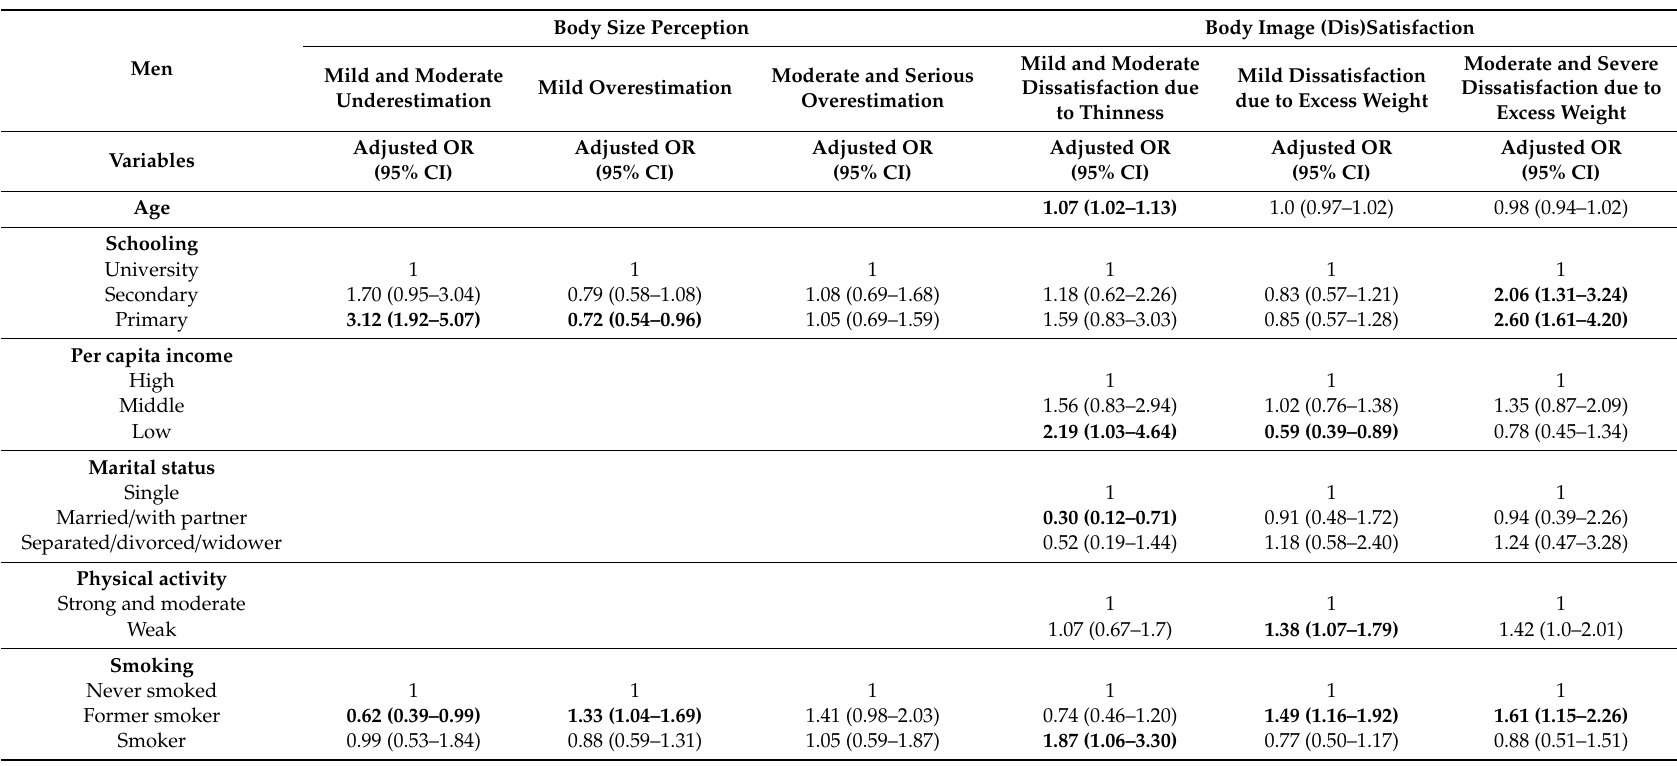
Table 4. Final model for association between body size perception and body image (dis)satisfaction and sociodemographic and behavior factors in elderly men participating in the ELSA-Brasil study